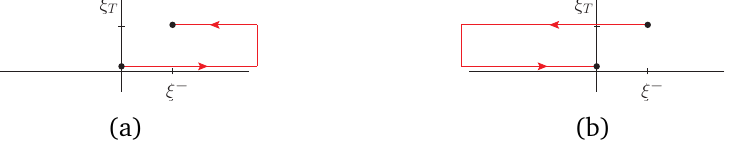
Figure 2: Representations of staple-like Wilson lines running from 0 to ξ in the hy- perplane defined by the minus component and the transverse components of ξ : the future-pointing Wilson line U + (a) and the past-pointing Wilson line U −